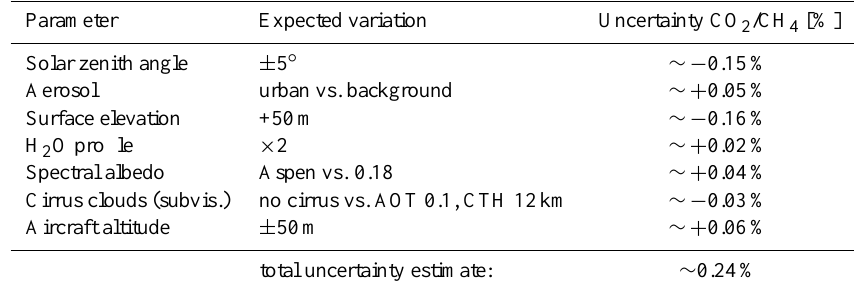
Table 9. Typical uncertainties to be generally expected in a standard retrieval of X CO 2 using the CH 4 proxy method for an albedo of 0.18, an aerosol background scenario and a reference aircraft altitude of